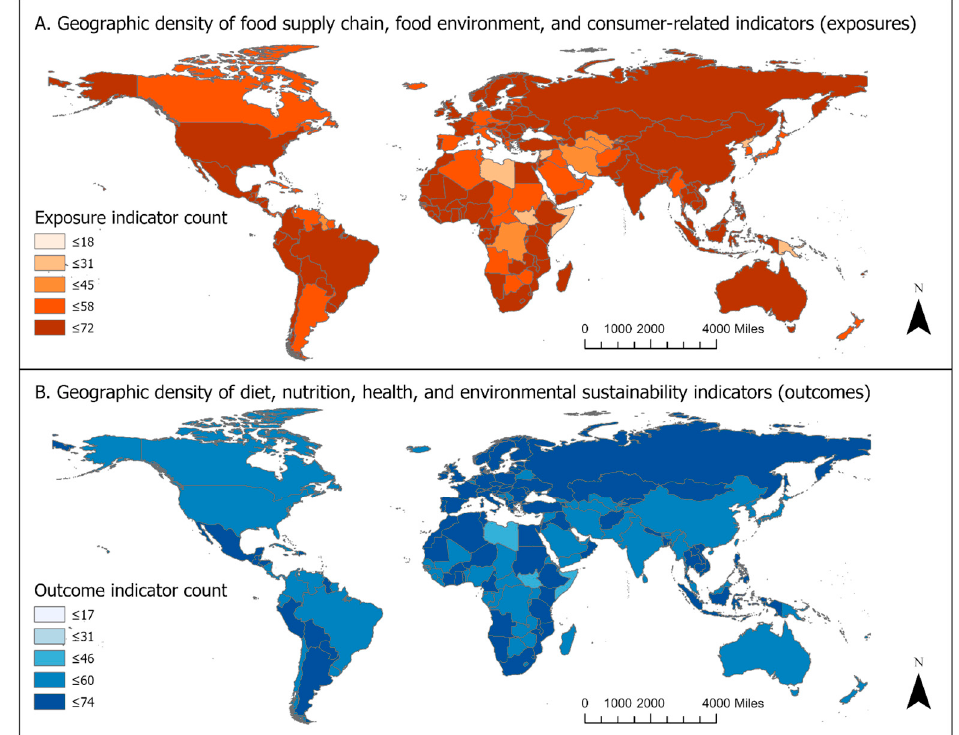
Figure 2. Food system-related indicator availability in the FSD.